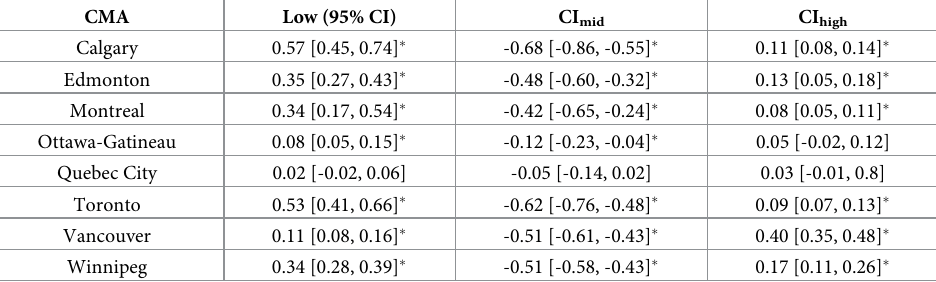
Table 2. Slopes of the three income groups (low, middle & high) and their associated 95% confidence intervals (CI) obtained via non-parametric bootstrapping of individual income